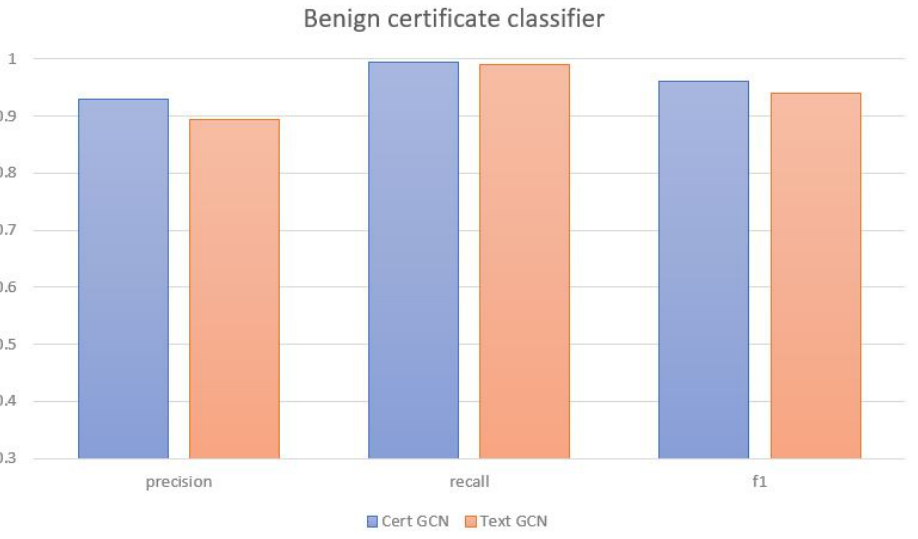
Figure 9. Accuracy, recall, and F1 values for Cert GCN and Text GCN benign certificate